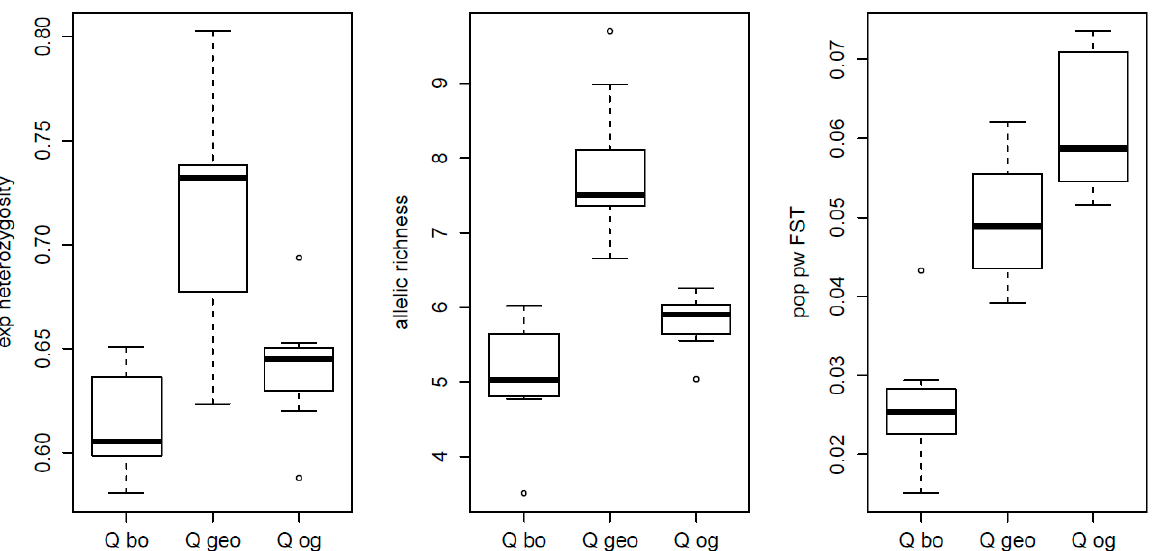
Figure 2. Species genetic diversity boxplots across populations comparing expected heterozygosity (exp heterozygosity), allelic richness, and F ST . (pop pw F ST ) Species are arranged by range size, with the smallest range on the left ( Q. boyntonii , “Q bo”), followed by Q. georgiana (“Q geo”), and the largest species range on the right ( Q. oglethorpensis , “Q og”). Only nuclear SSRs are included in this analysis.